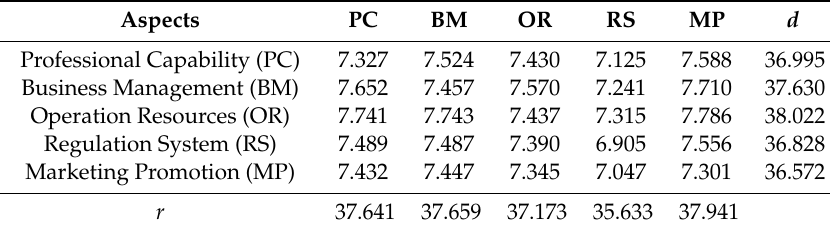
Table 8. The full influence matrix ( T ).